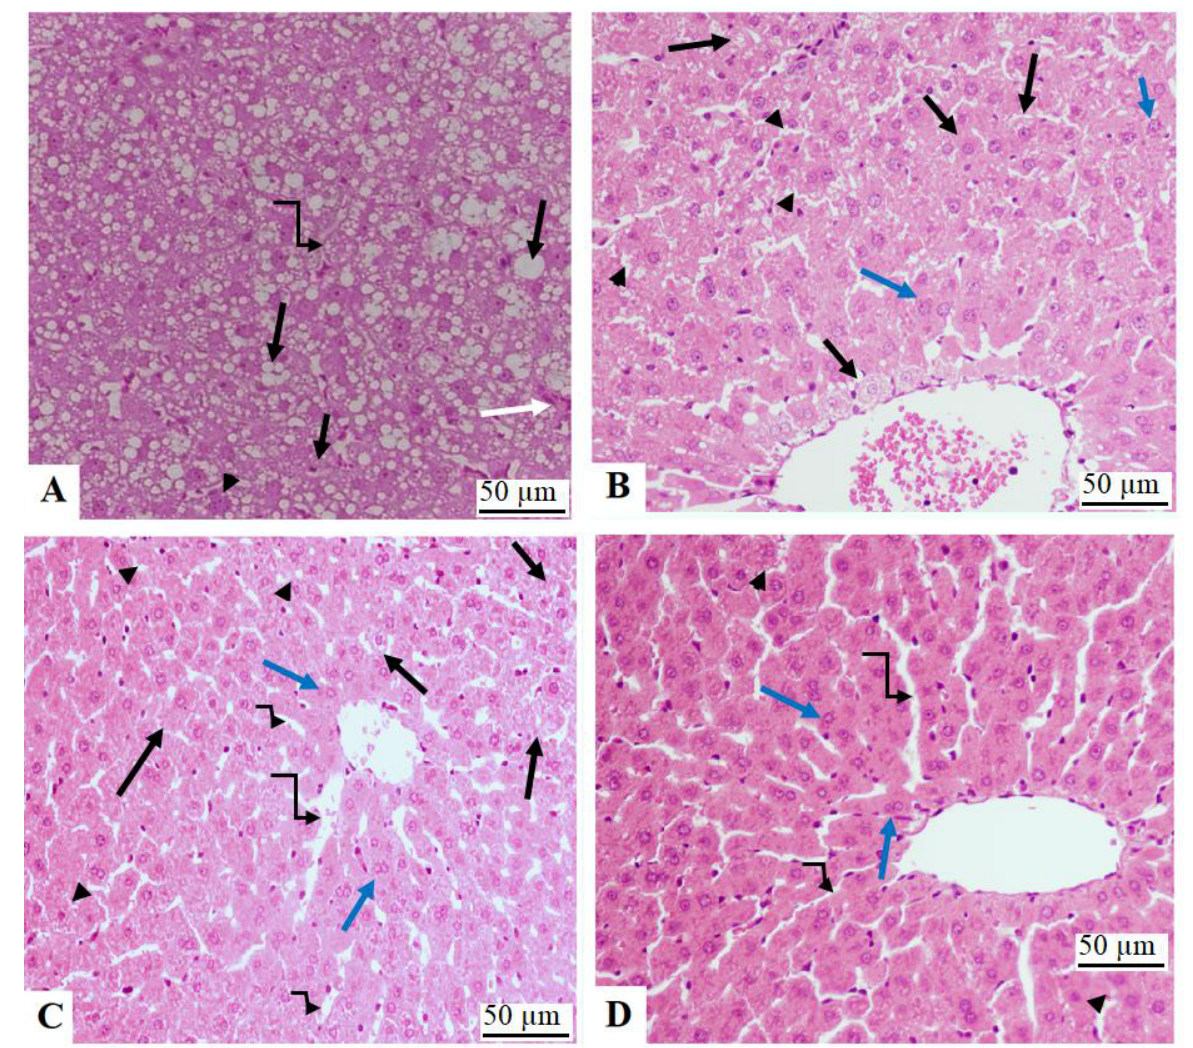
Figure 6. Liver sections from HFD model rats and other HFD treated groups: ( A ): was taken from HFD-fed animals and showed increased fat accumulation in the cell cytoplasm and the appearance of large fat vacuoles (long black arrow). Note the increased number of cells with karyolysis (black arrowhead), pyknosis (short arrow), and karyorrhexis (short black arrow). In addition, immune cell infiltration was evident (white arrow). ( B , C ): were taken from HFD + NAC and HFD + γ -Oryzanol-treated animals, respectively, and showed an obvious improvement in liver structure with an increased number of normal cells (Blue arrow) and sinusoids (small curved arrow). However, some pathological findings, including swollen cells (long black arrowhead), cells filled with fat (long large arrow), dilated sinusoids (large, curved arrow), and necrotic cells (very long black arrow), are still seen. ( D ): was taken from an HFD + γ -Oryzanol-treated rat and showed almost normal liver features like the control group. The majority of the cells in the field (long black arrow), as well as the sinusoids (short curve arrow), appeared normal. However, some necrotic cells (black arrowhead) and dilated sinusoids (long curved arrow) are still present but were few.